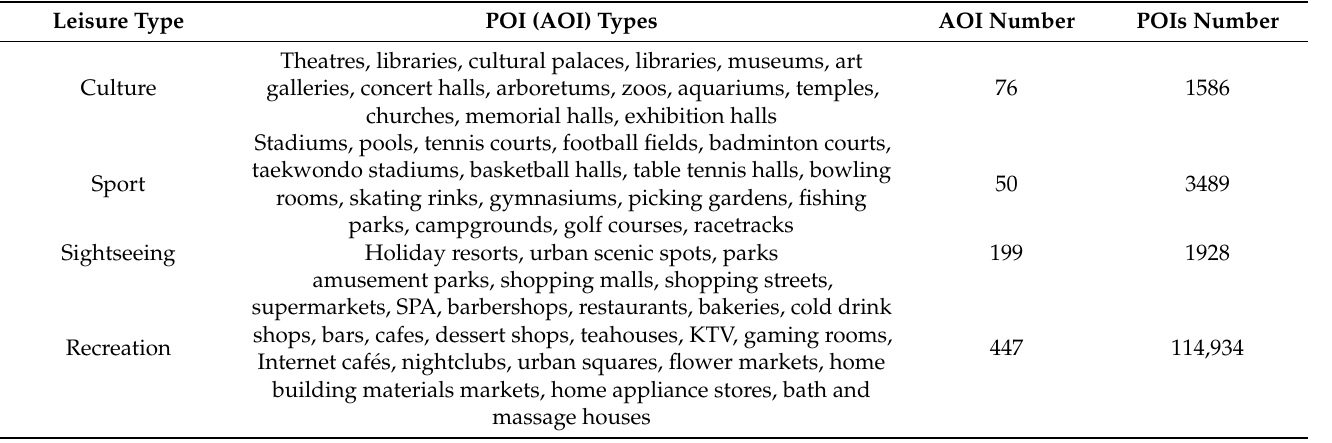
Table 2. Classification of leisure-related POIs and AOIs, and statistics on the number of these data collected in Nanjing. Leisure